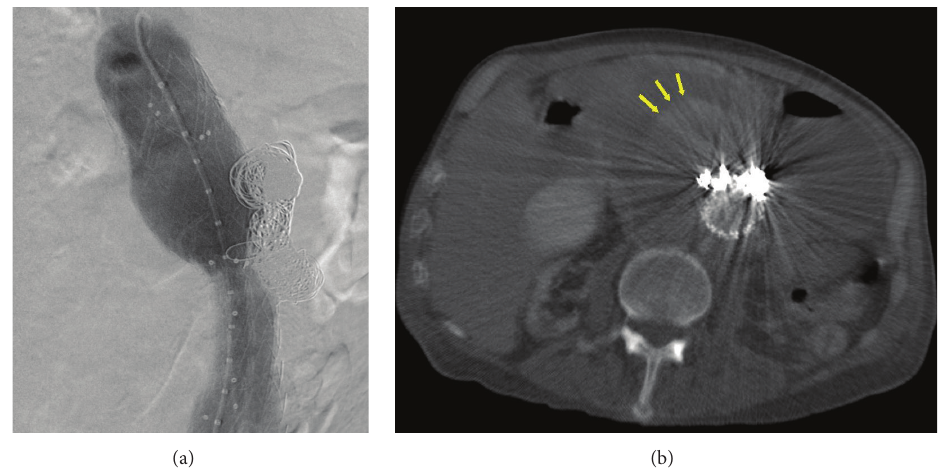
Figure 3: (a) Angiogram showed the complete disappearance of type 3b endoleak. (b) CT angiography showing peripheral high-density area in the sac, which could be related to fresh clot or residual contrast media during coils